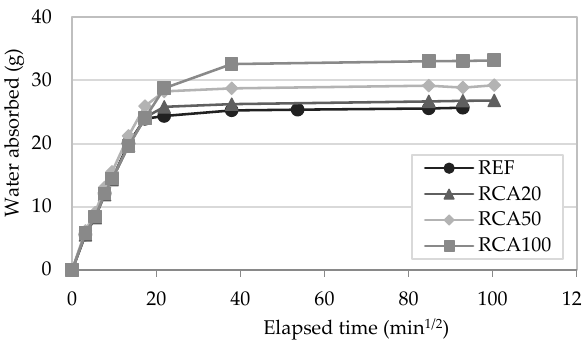
Figure 7. Capillarity coefficient of the mortars.